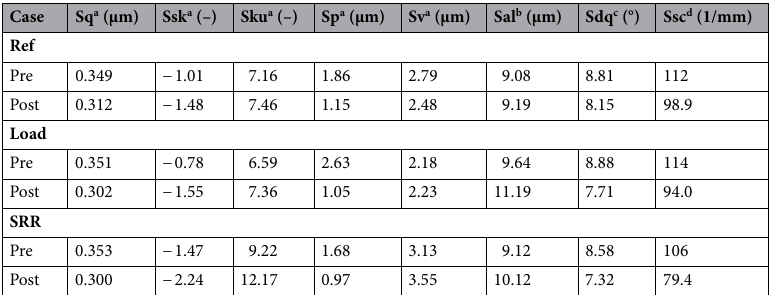
Table 1. Surface roughness parameters evaluated on exactly the same area before and after running-in. a Height: Root-mean-square average (RMS/Sq), skewness (Ssk), kurtosis (Sku), maximum peak height